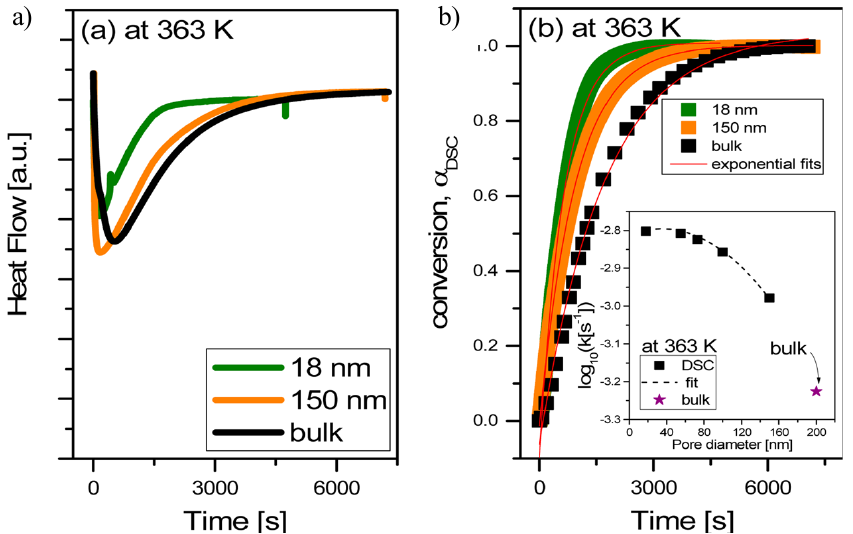
Figure 8. ( a ) Raw isothermal DSC data. ( b ) Time evolution of the monomer conversion determined from DSC measurements. As an inset in panel ( b ), the dependence of the polymerization rate constant vs. pore diameter is presented [128]. Copyright 2016. Reproduced with permission from the publisher: RSC.